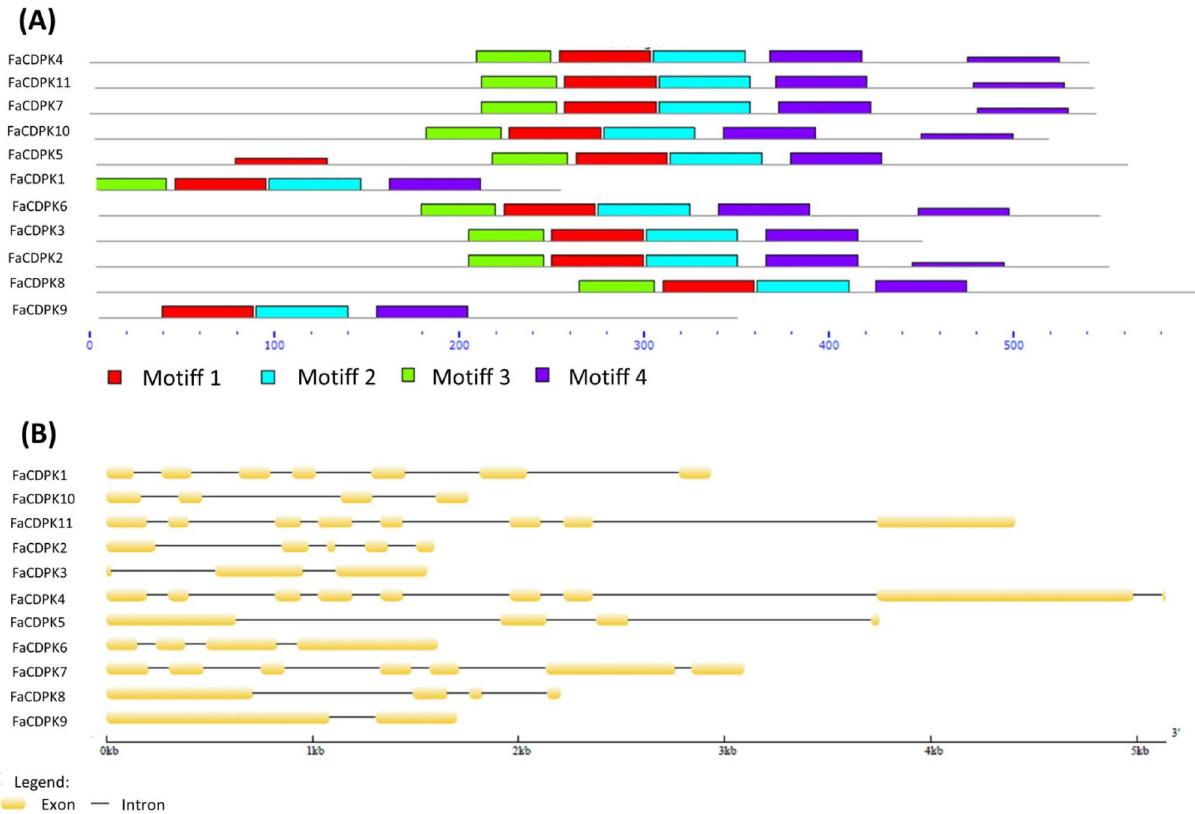
Figure 1. ( A ) Organization of the different motifs in 11 calcium-dependent protein kinases (CDPK) genes present in Fragaria x ananassa . Preserved motifs were detected using the online MEME tools (https ://meme. sdsc.edu/meme/intro .html). ( B ) Structure of the exons-introns in 11 calcium-dependent protein kinases (CDPK) genes present in Fragaria x ananassa. Exons and Introns are indicated by orange boxes and black lines,